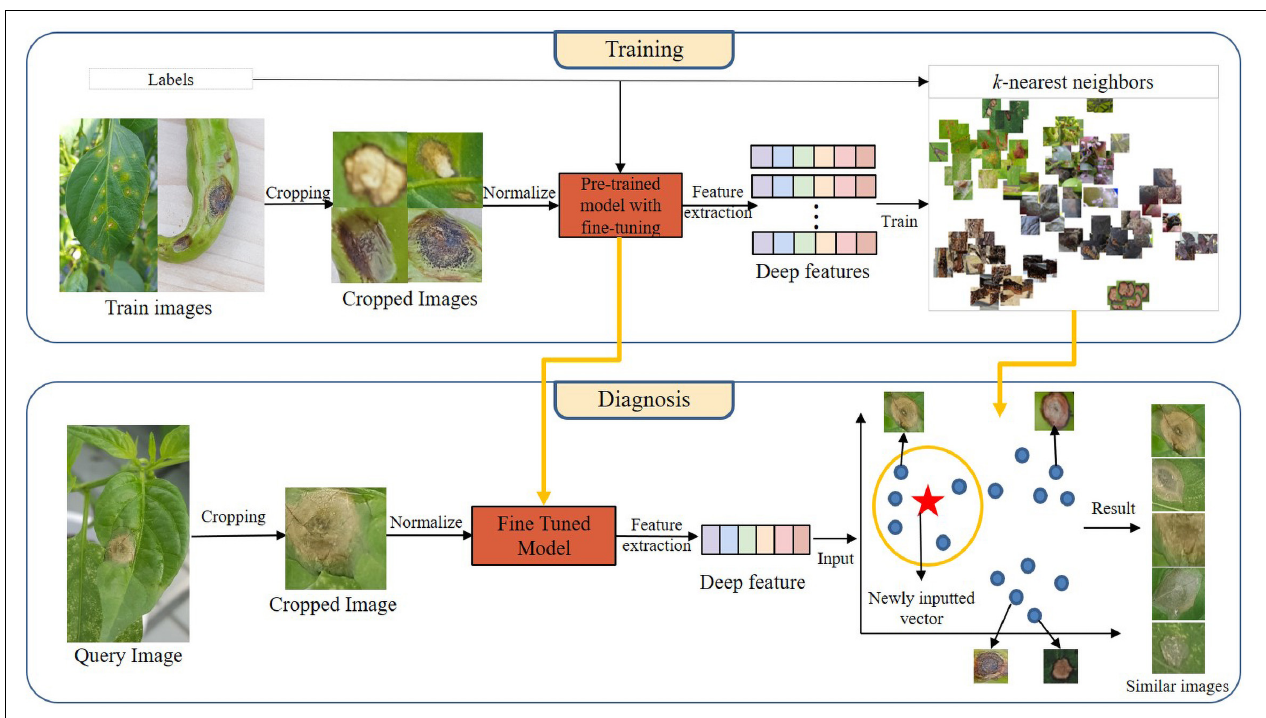
FIGURE 6 | The architecture of the proposed diagnostic